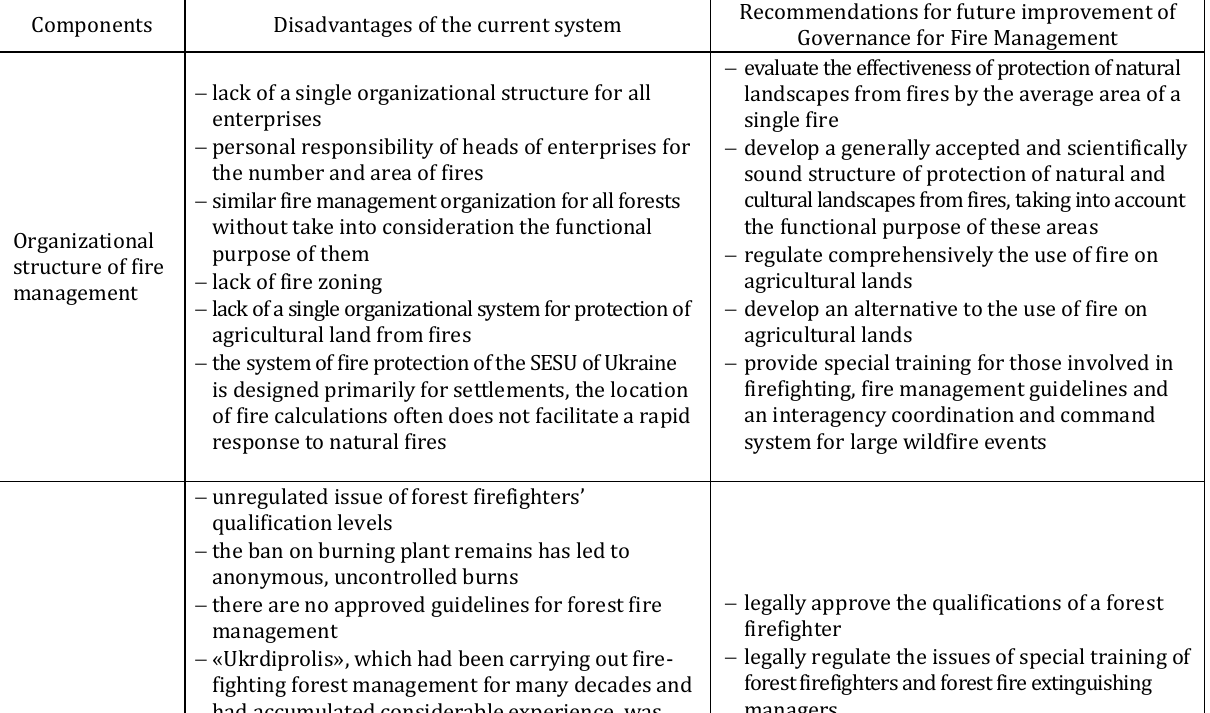
Table 1. Disadvantages of the current system and brief recommendations for measures to be taken to prepare the